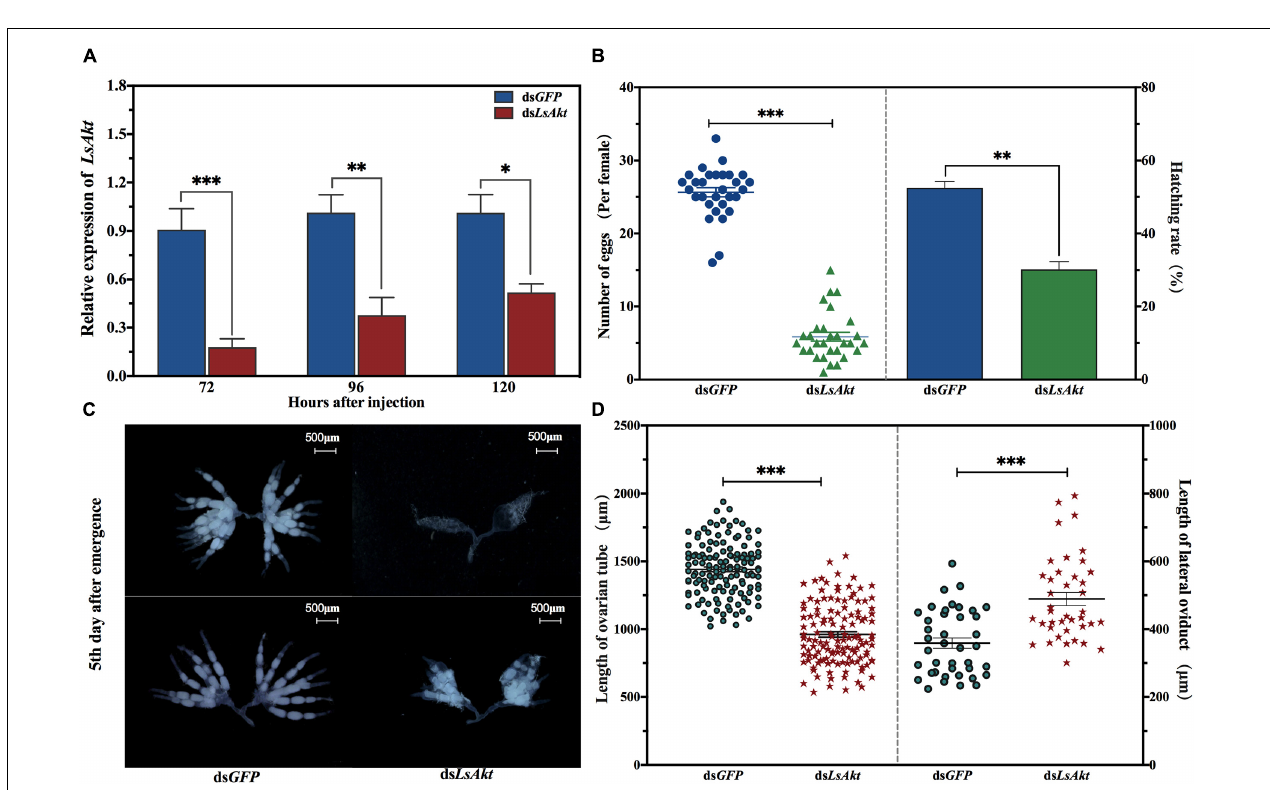
FIGURE 3 | Expression profiles of LsAkt after exogenous hormone treatments. (A) Effect of 20E and methoprene on the expression of LsAkt . Control: insects injected with distilled water containing 0.1% ethanol; 20E: insects injected with 20E (120 ng/pupa); Methoprene; insects injected with methoprene (200 ng/pupa). (B) Effect of insulin on the expression of LsAkt . Control: insects injected with HEPES buffer; insulin, insects injected with bovine insulin (300 ng/pupa). Significant differences between treatment group and control group at the same point were determined using Student’s t -test ( ∗ P < 0.05, ∗∗∗ P < 0.001).